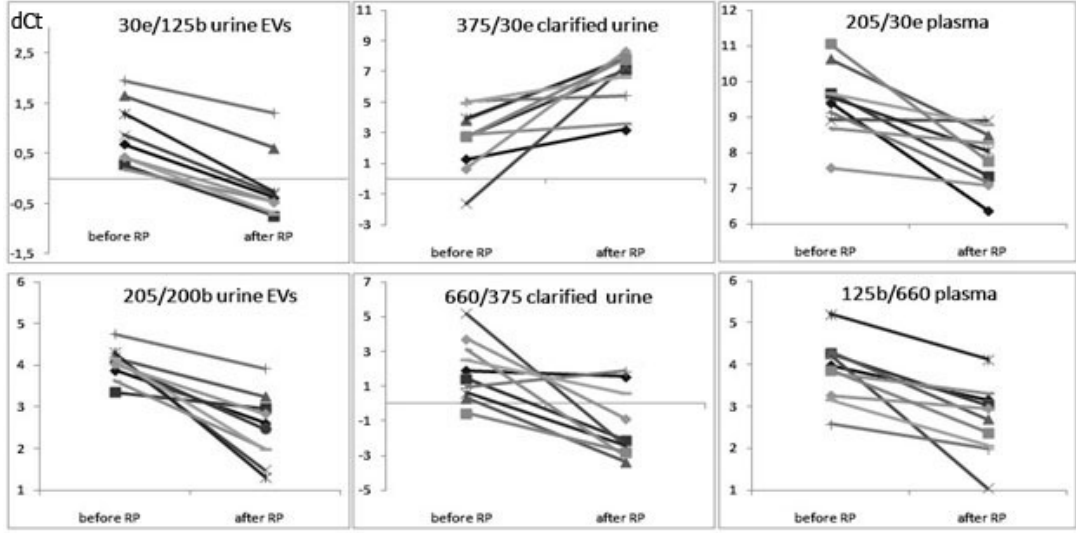
Figure 1. Examples of the miRNA ratios (dCt) whose expression was altered after RP of prostate cancer (PCa) patients. Wilcoxon signed-rank test, p < 0.01. EVs—extracellular vesicles; RP—radical prostatectomy. Different colored lines represent different donors.